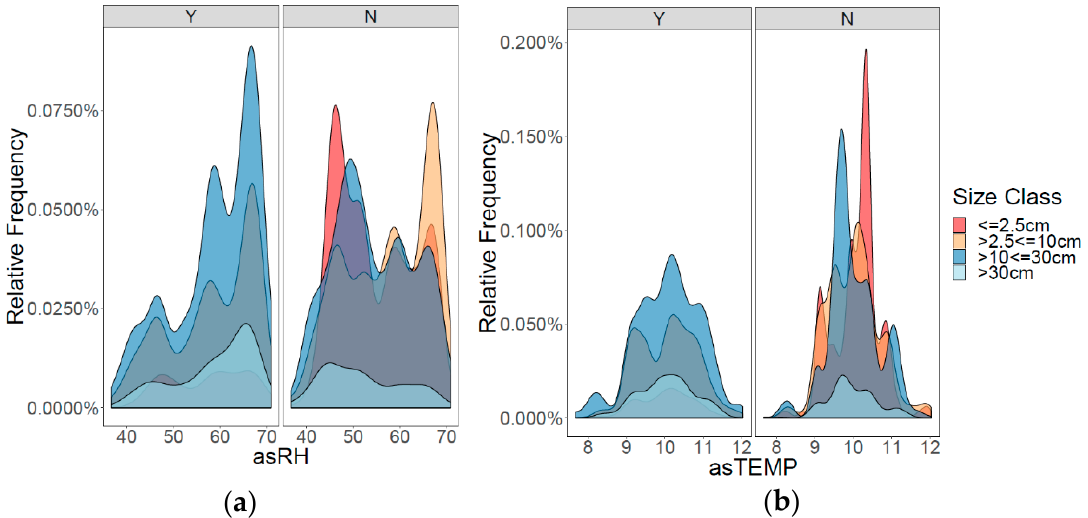
Figure 4. Proportion of whitebark pine trees infected and uninfected by white pine blister rust relative to ( a ) August and September average relative humidity, and ( b ) August and September average temperature (°C).